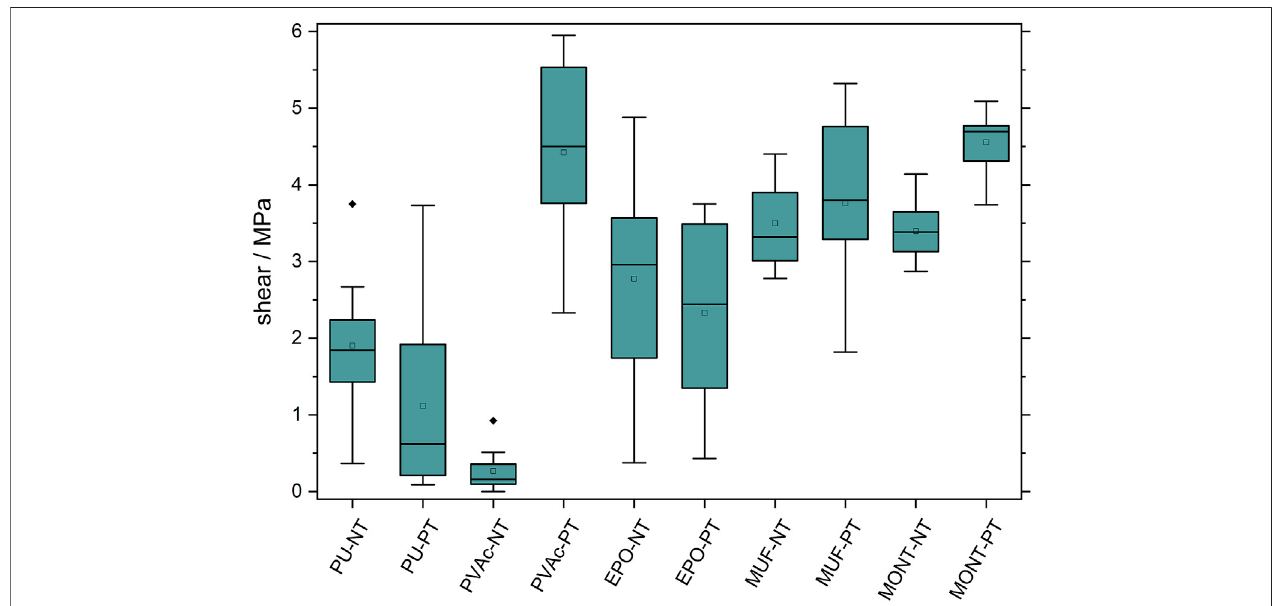
FIGURE 3 | Adhesive shear strength results for plasma-treated (PT) and not treated (NT) spruce and aluminum lamellae using polyurethane (PU), polyvinyl acetate (PVAc), epoxy (EPO), melamine urea-formaldehyde (MUF) and construction adhesive (MONT).